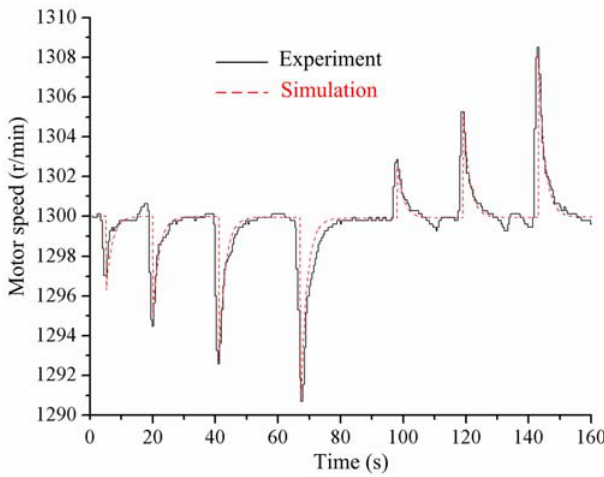
Figure 12. Motor speed responses of the HESGS under varied load power step. Energies 2018 , 11 , x FOR PEER REVIEW